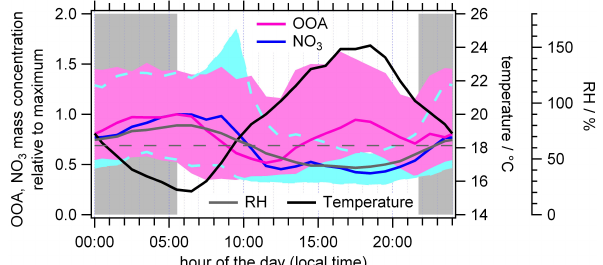
Fig. 7. Diurnal cycles (hourly median values) for the whole mea- surement campaign for the temperature and RH, and diurnal cycles for NO 3 and OOA, normalized to their respective maxima, all mea- sured at Sub NE. Percentiles (25 and 75%) are shown in light pink for OOA, and in light blue for NO 3 . The time period between sun- set and sunrise is shaded in grey. Deliquescence RH for NH 4 NO 3 of 62% (for 20 ◦ C; Seinfeld and Pandis, 2006) for the transition of the solid to the liquid phase is marked as a dashed horizontal